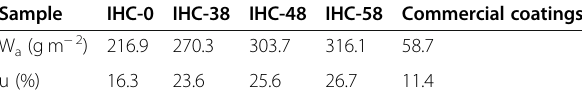
Table 2 Moisture buffering capacities and contents of IHC-s and commercial coating